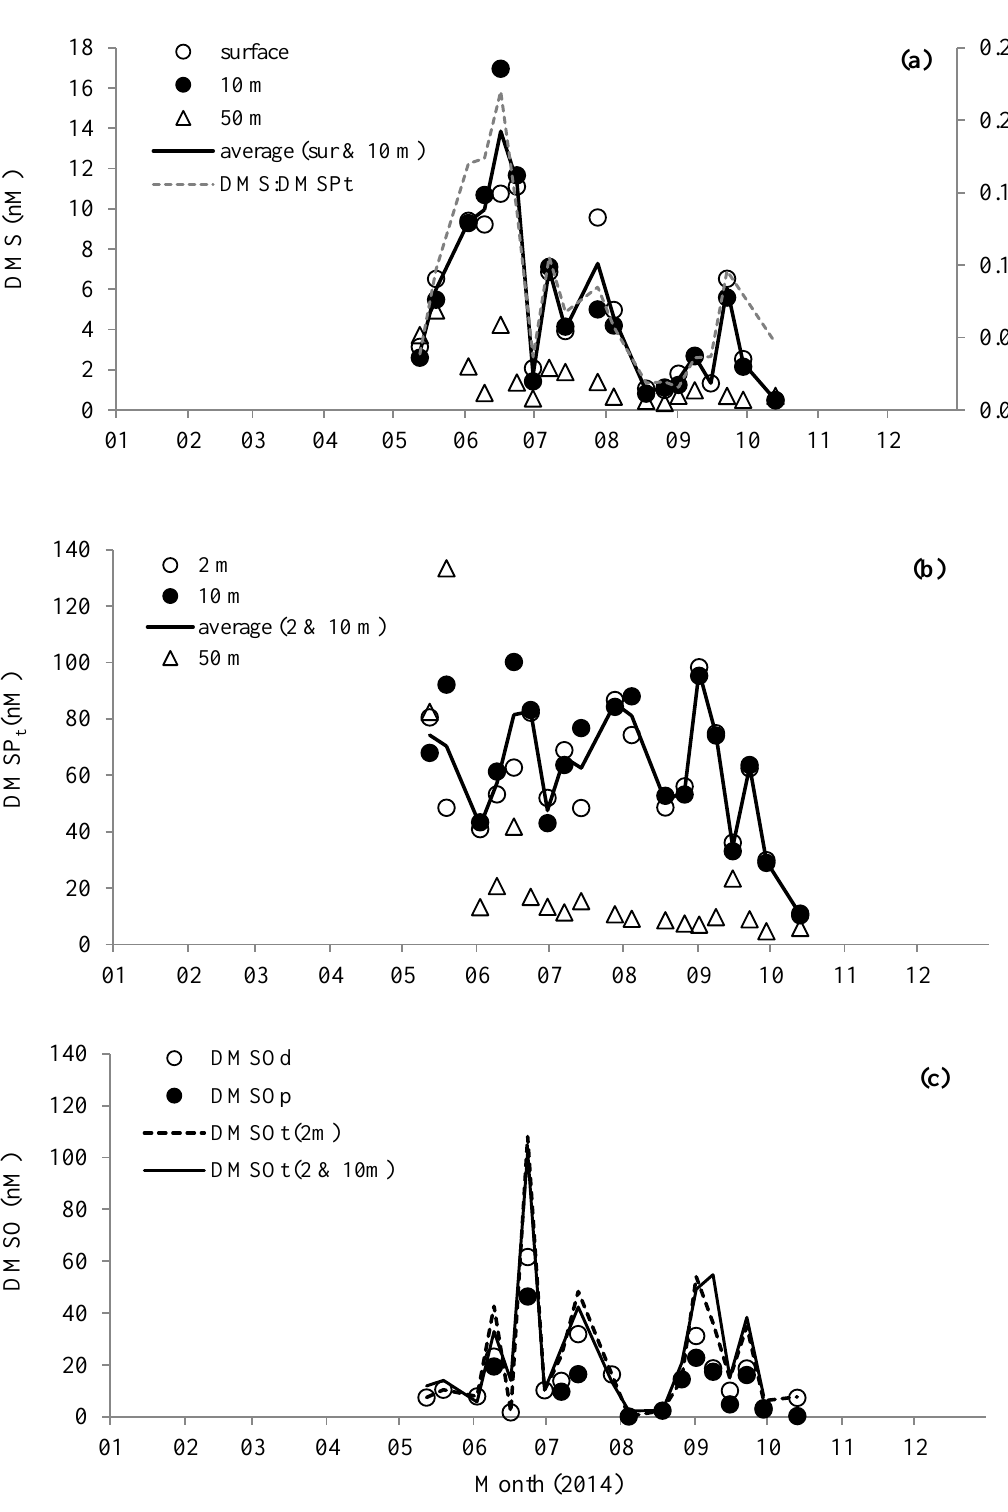
Figure 3. Changes in concentrations of ( a ) dimethylsulfide (DMS) and average molar ratio of DMS/total dimethylsulfoniopropionate (DMSP t ), ( b ) DMSP t , and ( c ) dimethylsulphoxide (DMSO) measured in the water column at station L4.